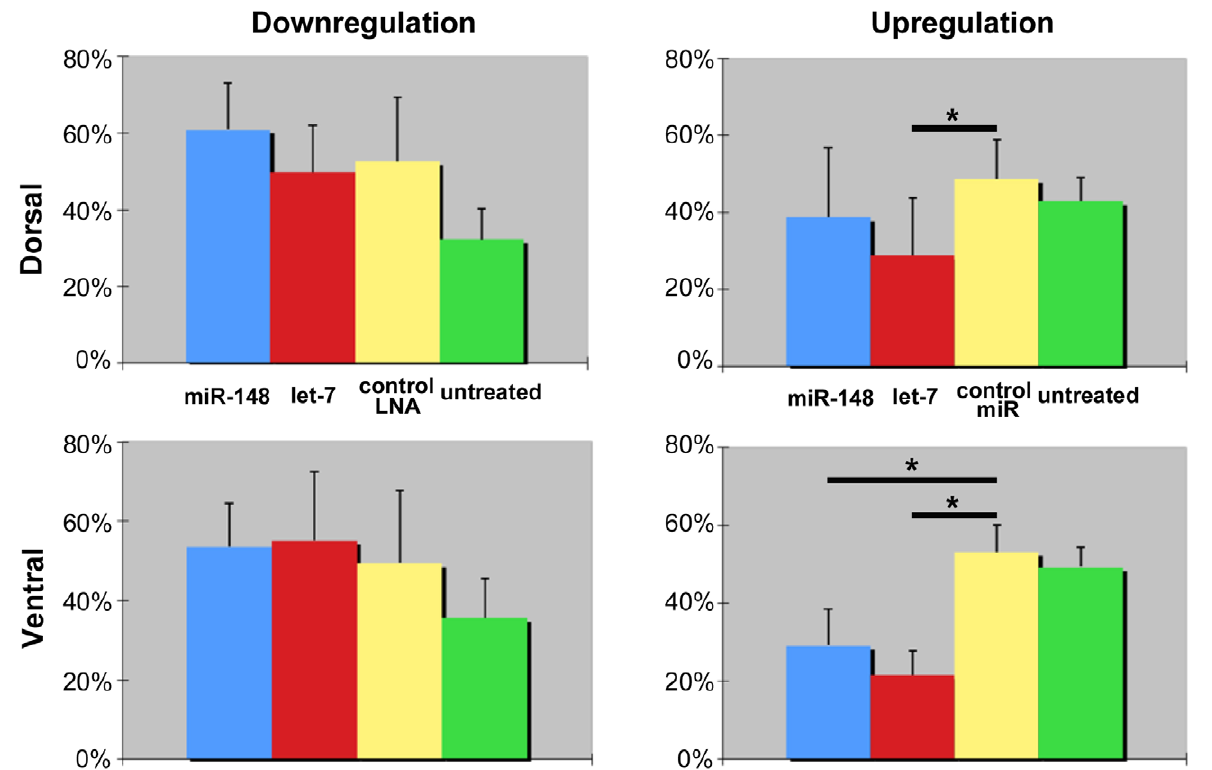
Figure 5. Quantitation of proliferation. Effects of gain or loss of function of miR-148 and let-7b on PEC proliferation.